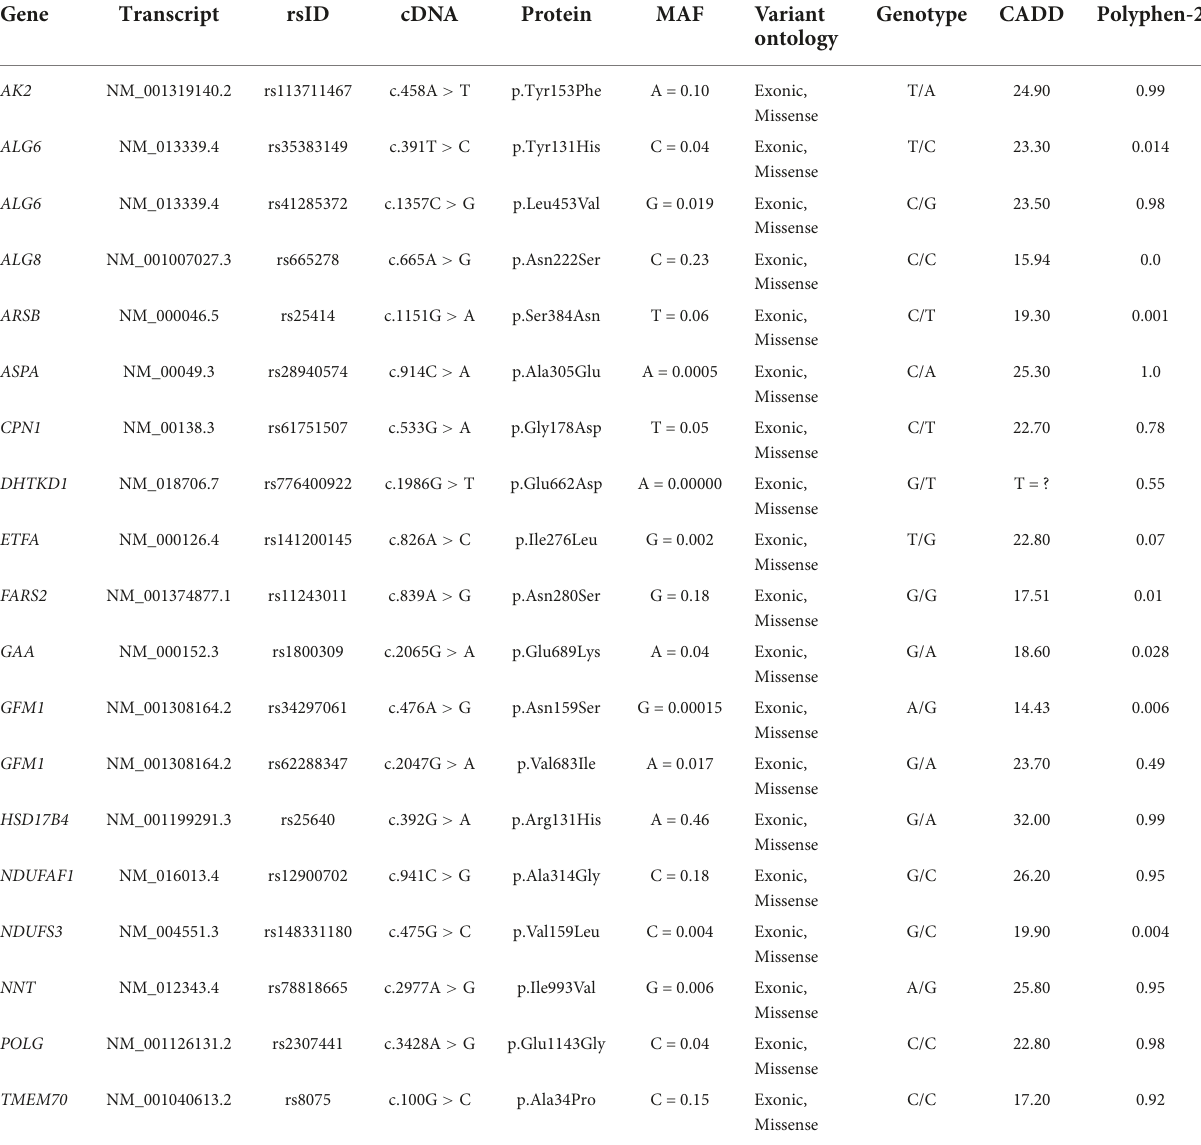
TABLE 3 Possibly pathogenic rare and common variants involved in mitochondrial biological processes, identified in the 40-year-old woman with